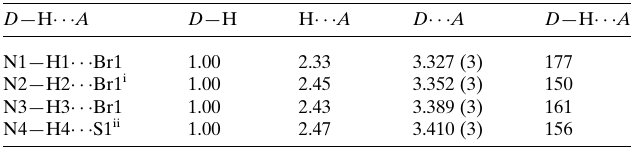
Table 1 Hydrogen-bond geometry (A˚ , (cid:4)